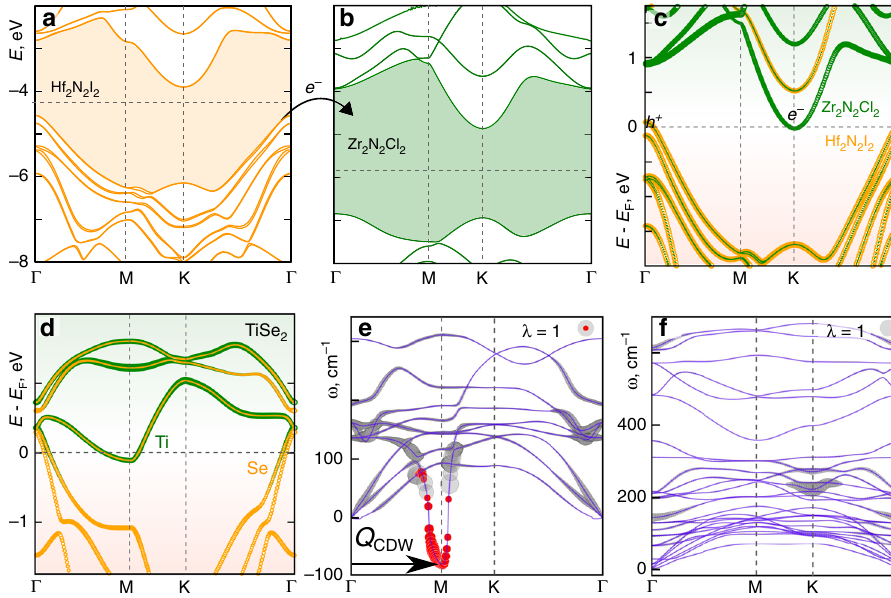
Fig. 4 Band structures and phonon spectra of 2D Hf 2 N 2 I 2 , Zr 2 N 2 Cl 2 , Hf 2 N 2 I 2 /Zr 2 N 2 Cl 2 , and 1 T TiSe 2 . Band alignment in a Hf 2 N 2 I 2 and b Zr 2 N 2 Cl 2 . Projected LDA band structures of c Hf 2 N 2 I 2 /Zr 2 N 2 Cl 2 heterostructure, and d 1 T TiSe 2 . LDA phonon dispersions with electron-phonon couplings λ of e 1 T TiSe 2 , and f Hf 2 N 2 I 2 /Zr 2 N 2 Cl 2 heterostructure. The area of the gray and red circles is proportional to the coupling strength λ